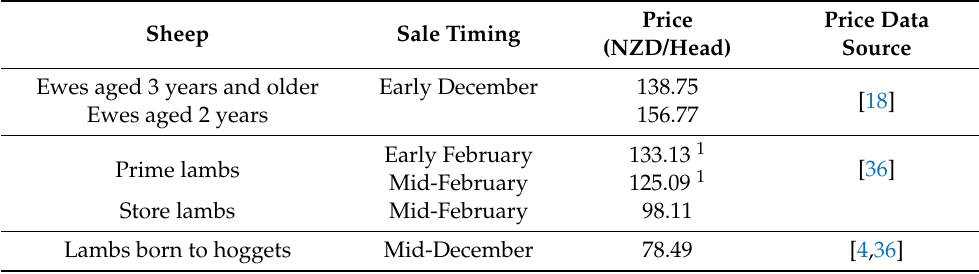
Table 1. Prices of sheep sold in 2019/20. Cull ewes, prime (sold direct to slaughter) lambs, and store (for a different farmer to grow to slaughter) lambs. Lambs from hoggets were sold store. Sheep Sale